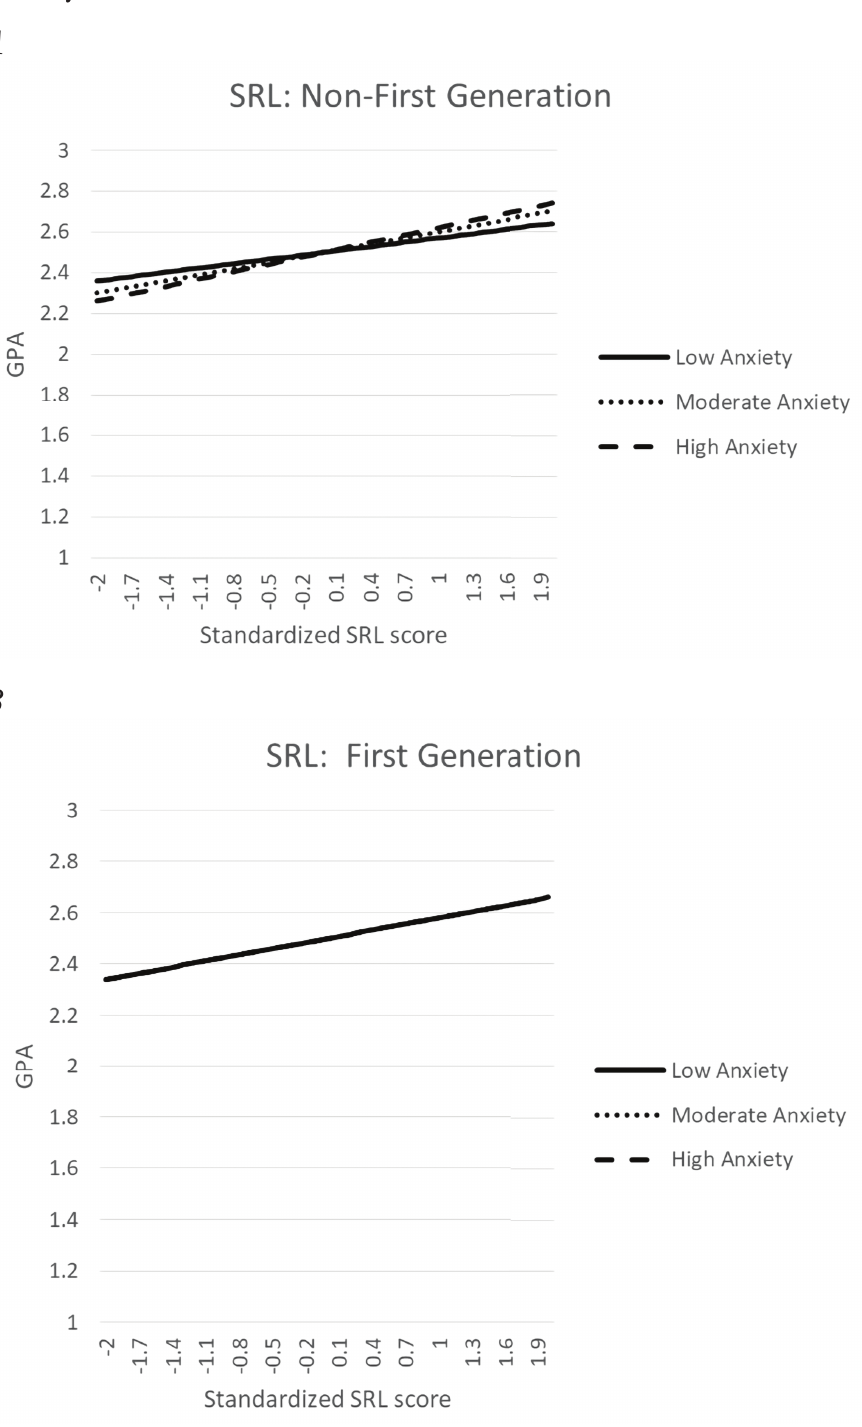
Figure 3. Total Relationship between SRL and GPA at Low, Moderate, and High